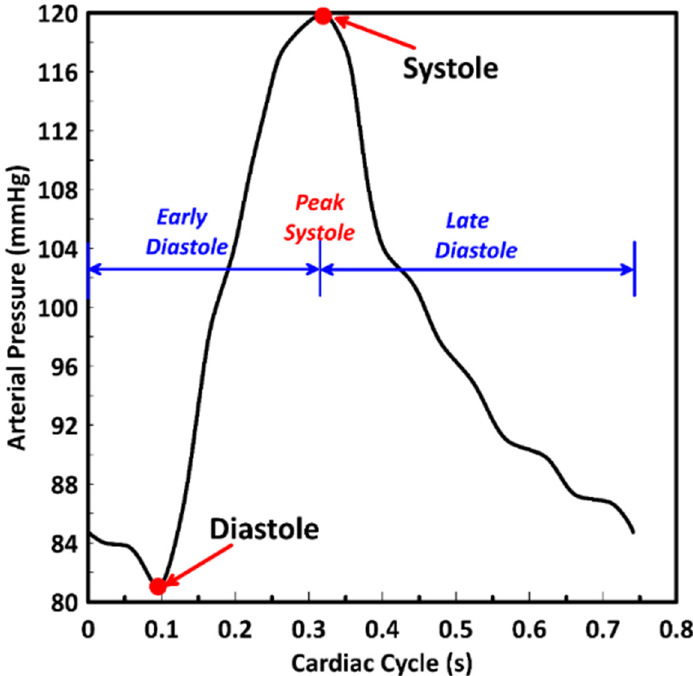
Figure 2. Inlet pressure distribution along the cardiac cycle represents the early diastole, peak systole, and late diastole periods.